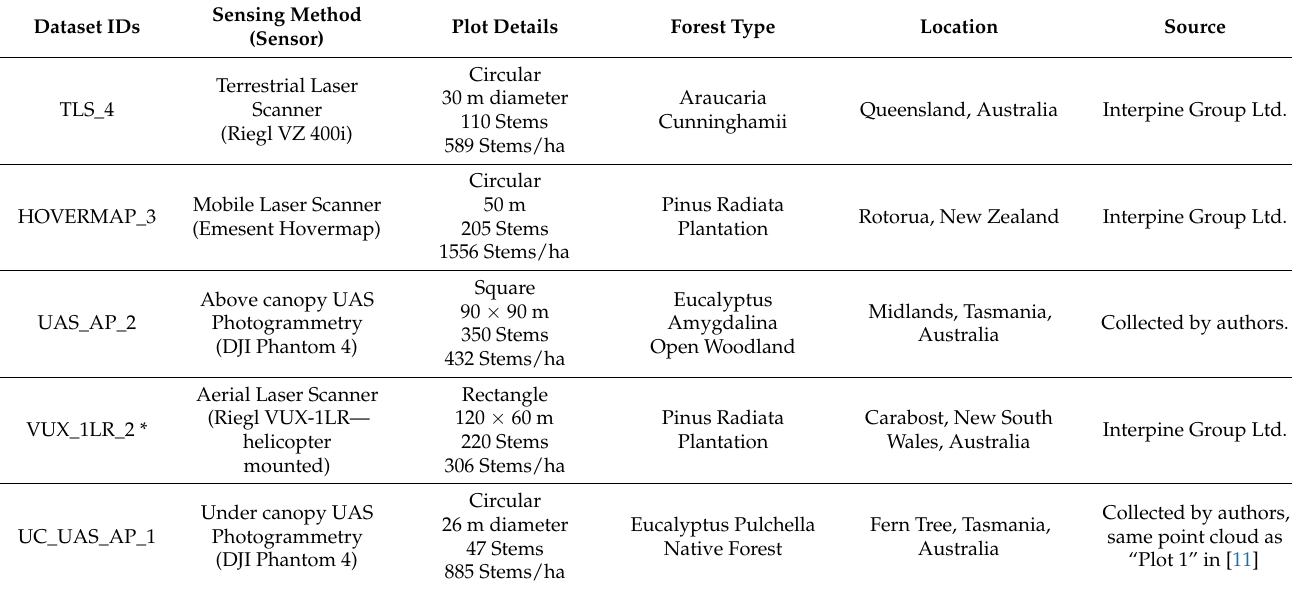
Table 2. Description of unlabeled point cloud datasets shown in the fly-through video. Counted stems were > 100 mm diameter at breast height. Stem counts were automatically extracted and not manually